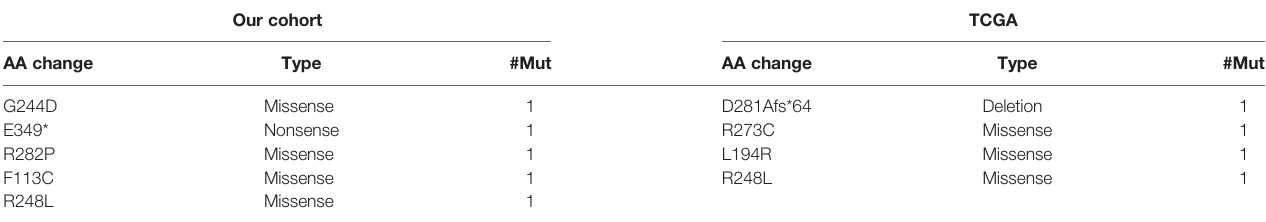
TABLE 3 | Frequency of different TP53 somatic mutations in Thymoma patients from our and TCGA cohort. Our